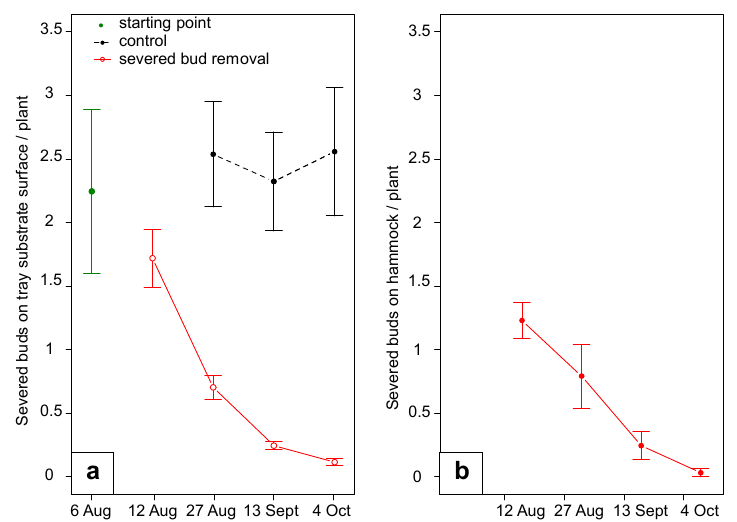
Figure 10. ( a ) Severed buds fallen onto the tray substrate surface and ( b ) intercepted by hammock. Error bars indicate standard error.